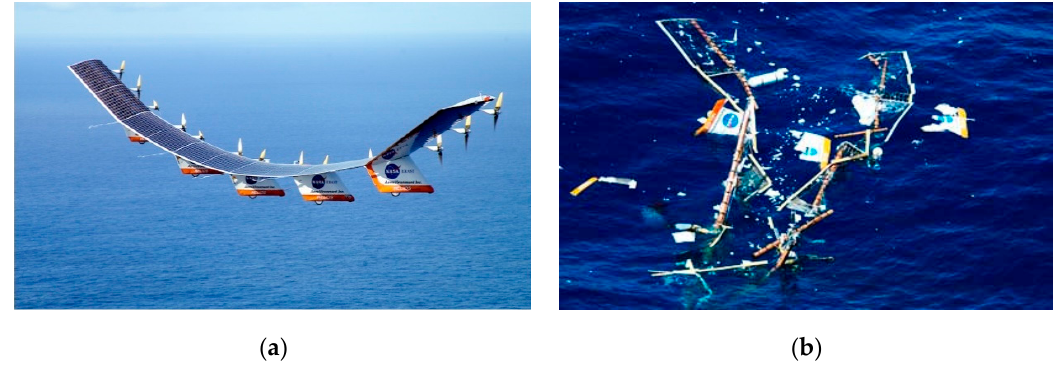
Figure 1. ( a ) Test photos of Helios Solar powered UAV; ( b ) Aerial disintegration photos of Helios [1–3].